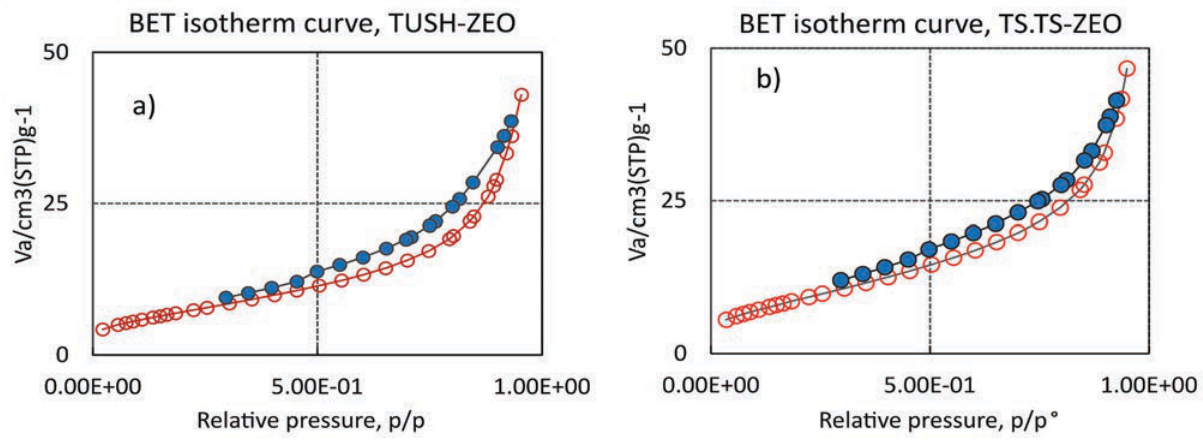
Fig. 3. Sorption isotherms of raw zeolites (a) TUSH-ZEO and (b) TS.TS-ZEO Table 1. BET surface analysis of TS.TS-ZEO and TUSH-ZEO Property